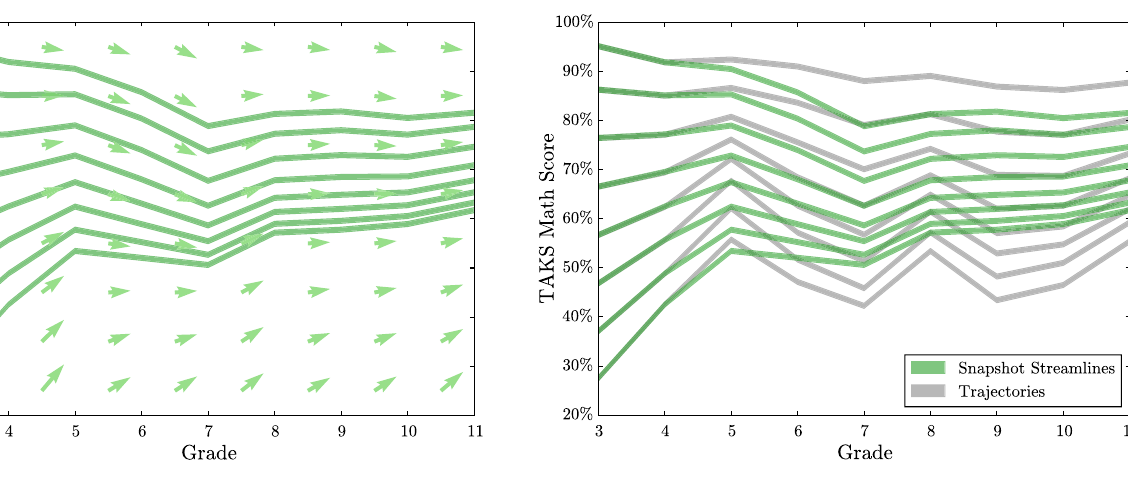
FIG. 6. Snapshot streamlines for 2003 – 2004 and trajectories for the cohort of 2012. The snapshot streamlines represent the synthetic cohort of 2003, whereas the trajectories represent the cohort of 2012. In the absence of cohort disparities, the snapshot streamlines could be used to predict the longitudinal performance of the students, which is represented by the trajectories. The convergence of the streamlines due to RTM makes the predictions from the snapshot streamlines observed scores on a single exam, the random component of their score may force the student into a different bin than their achievement might warrant. For a score distribution with more students performing near the mean than at the extremes, most of the “ wrongly binned ” students typically perform closer to the mean of the distribution. On a second exam, the average for the score bin will regress toward the